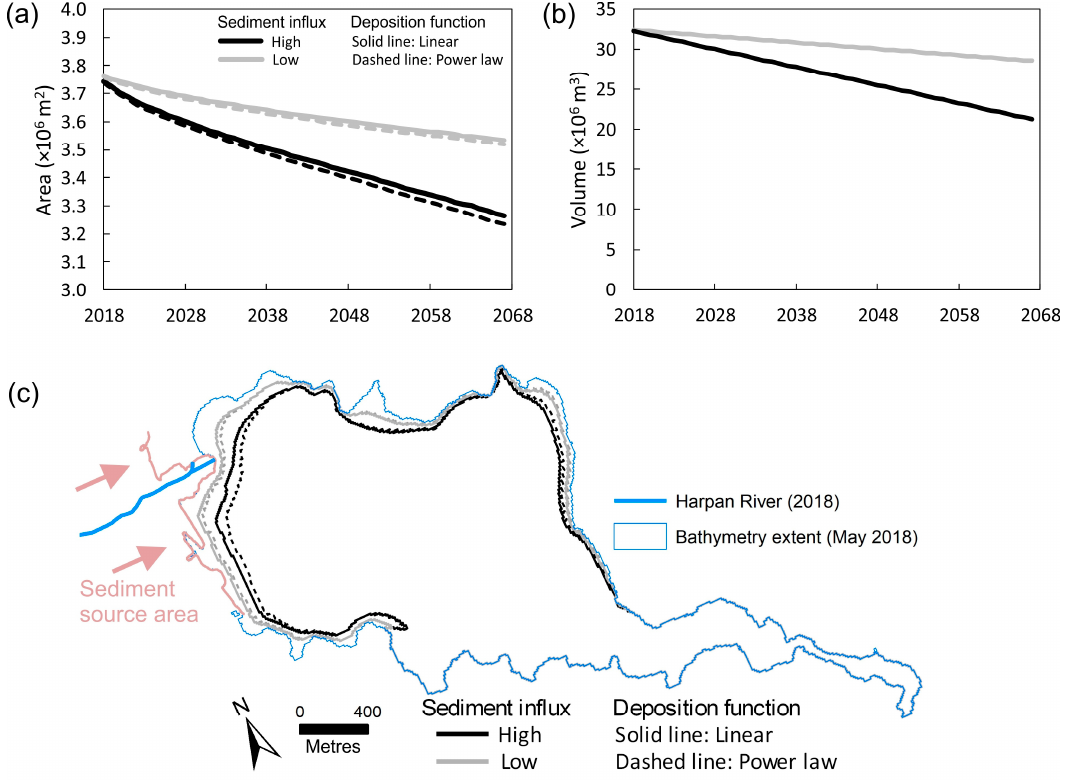
Figure 5. Modelled area (a) and volume (b) decrease for high and low sediment influx scenarios. (c) The resulting shoreline change to the year